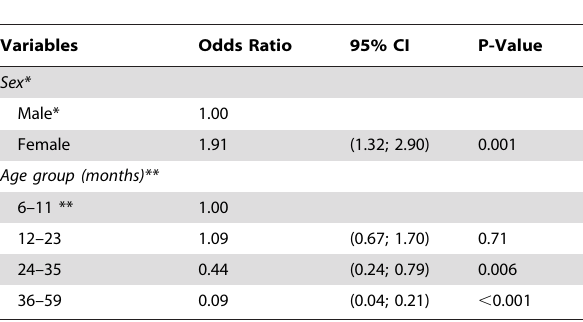
Table 5. Risk factors for acute